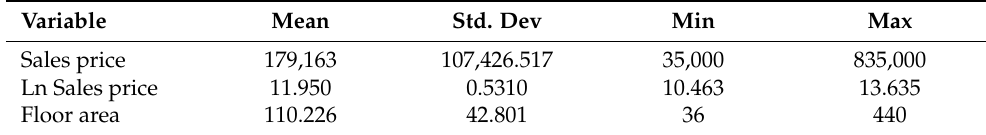
Table 2. Descriptive statistics of the property variables.